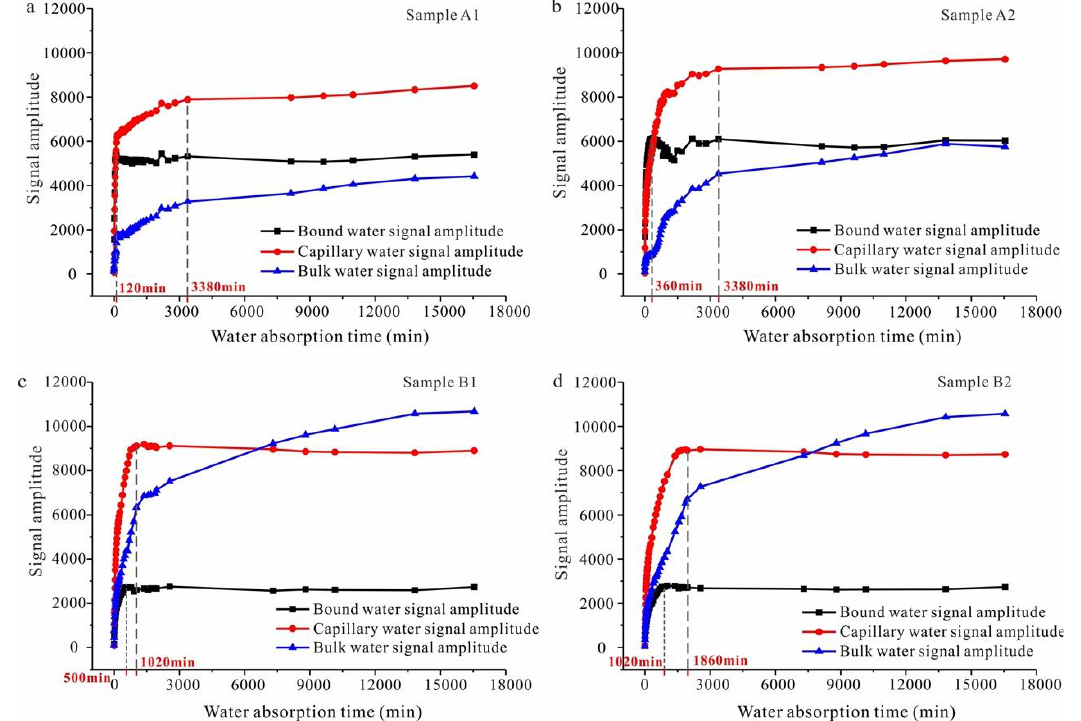
Figure 6. Water signal amplitudes from different types of water in ( a ) Sample A1; ( b ) Sample A2; ( c ) Sample B1 and ( d ) Sample B2.